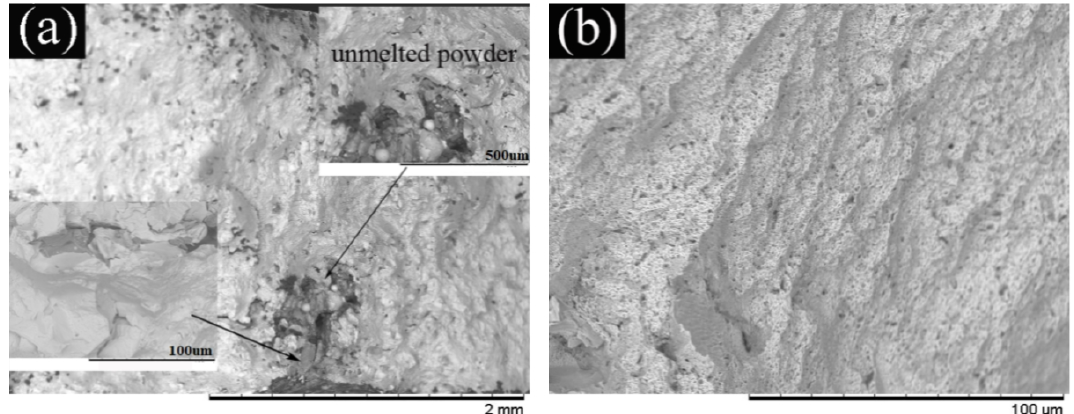
Figure 13. The SEM images of the fracture surface for the SLM specimen at room temperature: ( a ) low magnifications, ( b ) high magnifications.